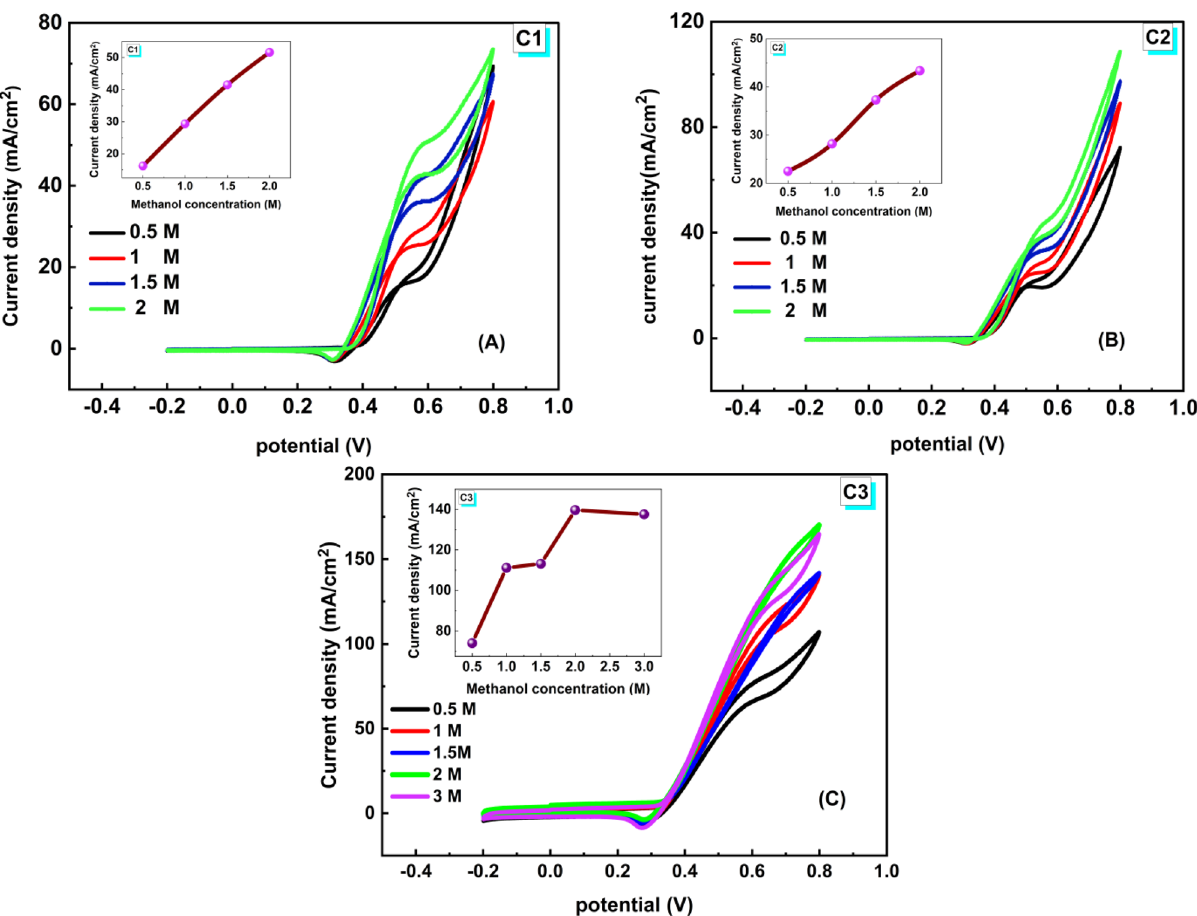
Figure 8. Electrocatalytic activity of the catalysts C1, C2, and C3 in 1.0 M KOH in the existence of 0.5, 1.0, 1.5, and 2 M of methanol, SR 100 mVs −1 . Inset: the relationship between the peak current and concentrations of